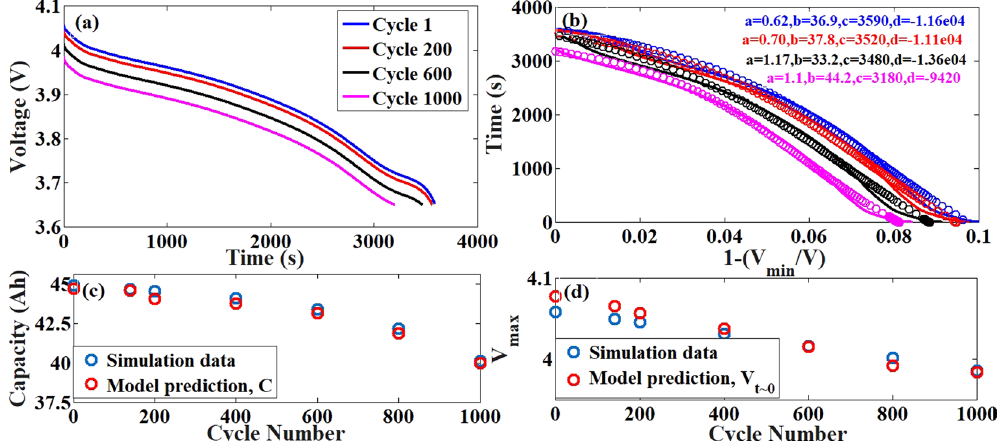
Figure 3. Comparison between simulation data and model prediction for the NG-LMO system with only the Anode SEI model. ( a ) The discharge profiles obtained from ECT simulations using the Anode SEI model. ( b ) The reduced parameter representation of the discharge curves in the new system (bold lines) and the model prediction (circles) with the parameter values mentioned in the legend. ( c ) The comparison of the capacity loss (available capacity) obtained from the simulations and the prediction from the model. The time taken for full discharge over a cycle is taken as a measure of the capacity. ( d ) The comparison of the resistance induced loss obtained from the simulations and the prediction from the model. The voltage at the start of discharge (V max ) is taken as a measure to predict the resistance induced loss. The maximum error between the predicted and actual data is < 0.5%.